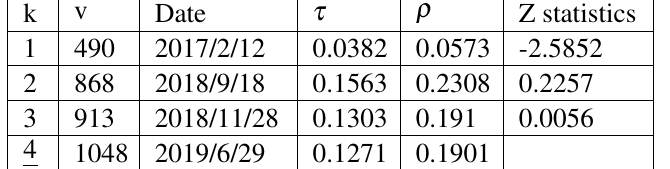
Table 10 Correlation structure between the Standard & Poor’s 500 Index and the SSE 300 Financial